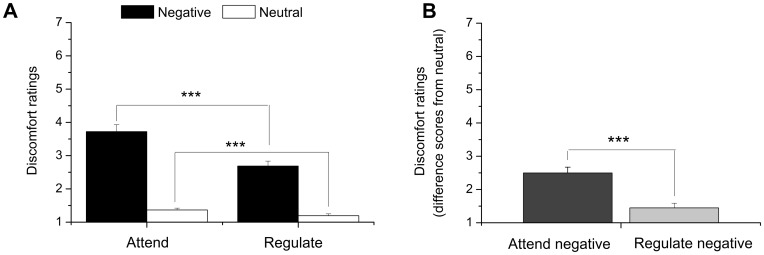
Behavioral results.Discomfort ratings were significantly lower during A. Reappraise negative vs. Attend negative trials and during Reappraise neutral vs. Attend neutral trials. B. Successful emotion regulation as revealed by significantly lower subjective ratings of discomfort during Reappraise negative trials compared to Attend negative trials expressed as difference scores from neutral trials. Errors bars represent SEM. *** = p<.001.